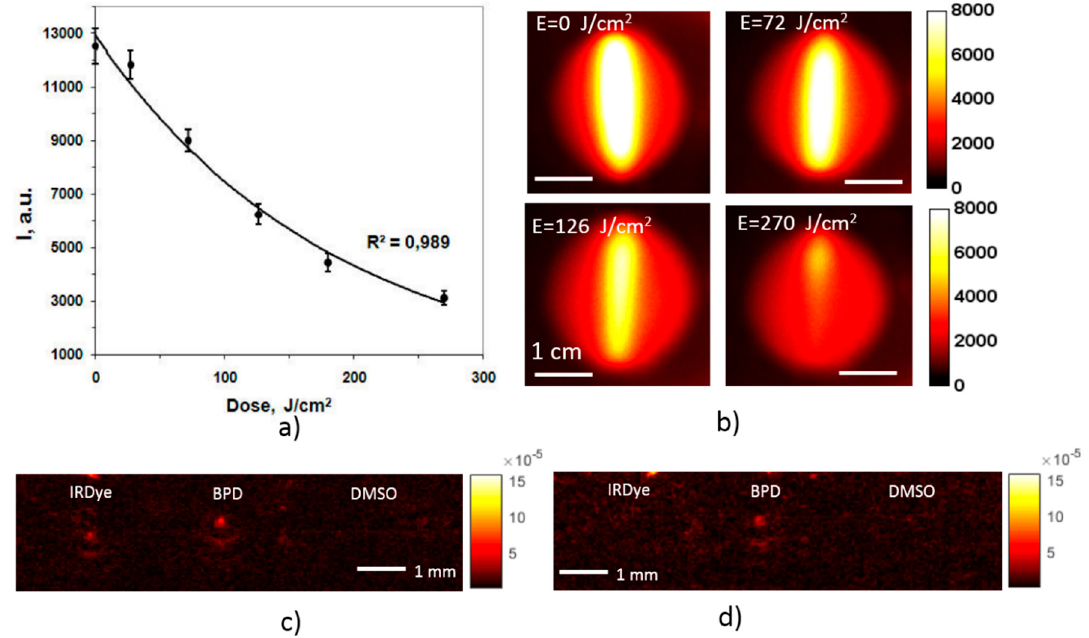
Figure 10. Dependence of the fluorescence signal in the course of BPD photobleaching on the delivered irradiation dose with the confidence bounds ( a ). Fluorescence images of a BPD-containing tube corresponding to the indicated doses ( b ), and OA B-scans at 690 nm before ( c ) and after ( d ) the PDT-mimicking procedure.